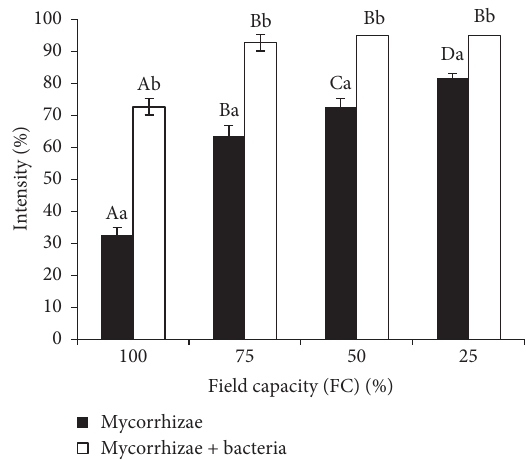
Figure 3: The intensity of colonization in mycorrhizae and mycorrhizae+bacteria plants under water deficit conditions. Vertical bars represent the standard deviation ( n � 3). Bars with different lowercase letters indicate significant differences between treatments at the same FC ( p < 0 . 05). Bars with different uppercase letters indicate significant differences in the same treatment at different FC percentages ( p < 0 .